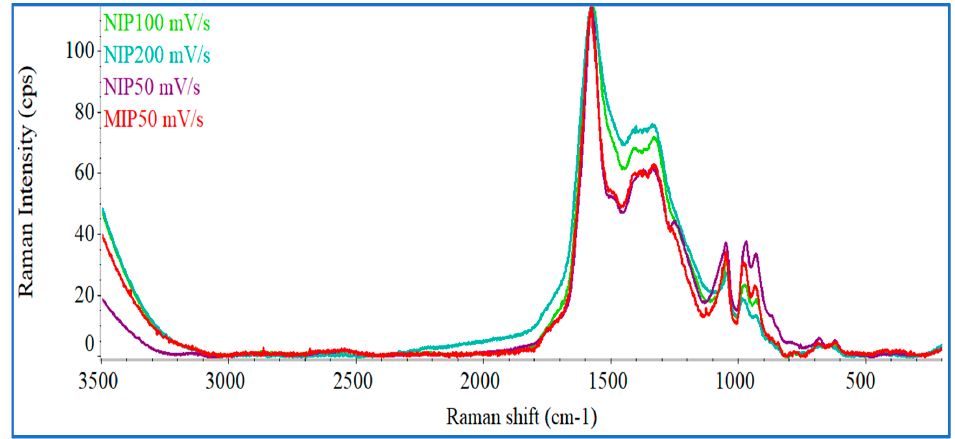
Figure 3. Raman spectra of NIP materials prepared with scan-rates of 50, 100 and 200 mV/s and the corresponding molecularly-imprinted polymers (MIPs) material with 50 mV/s.